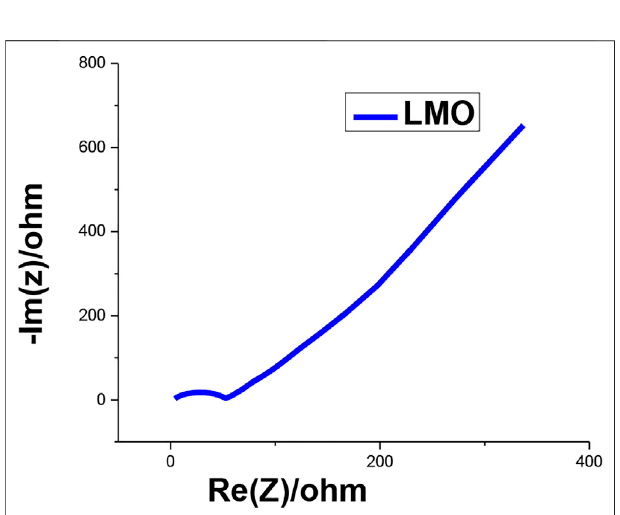
FIGURE 6 | EIS characterization of the synthesized LMO